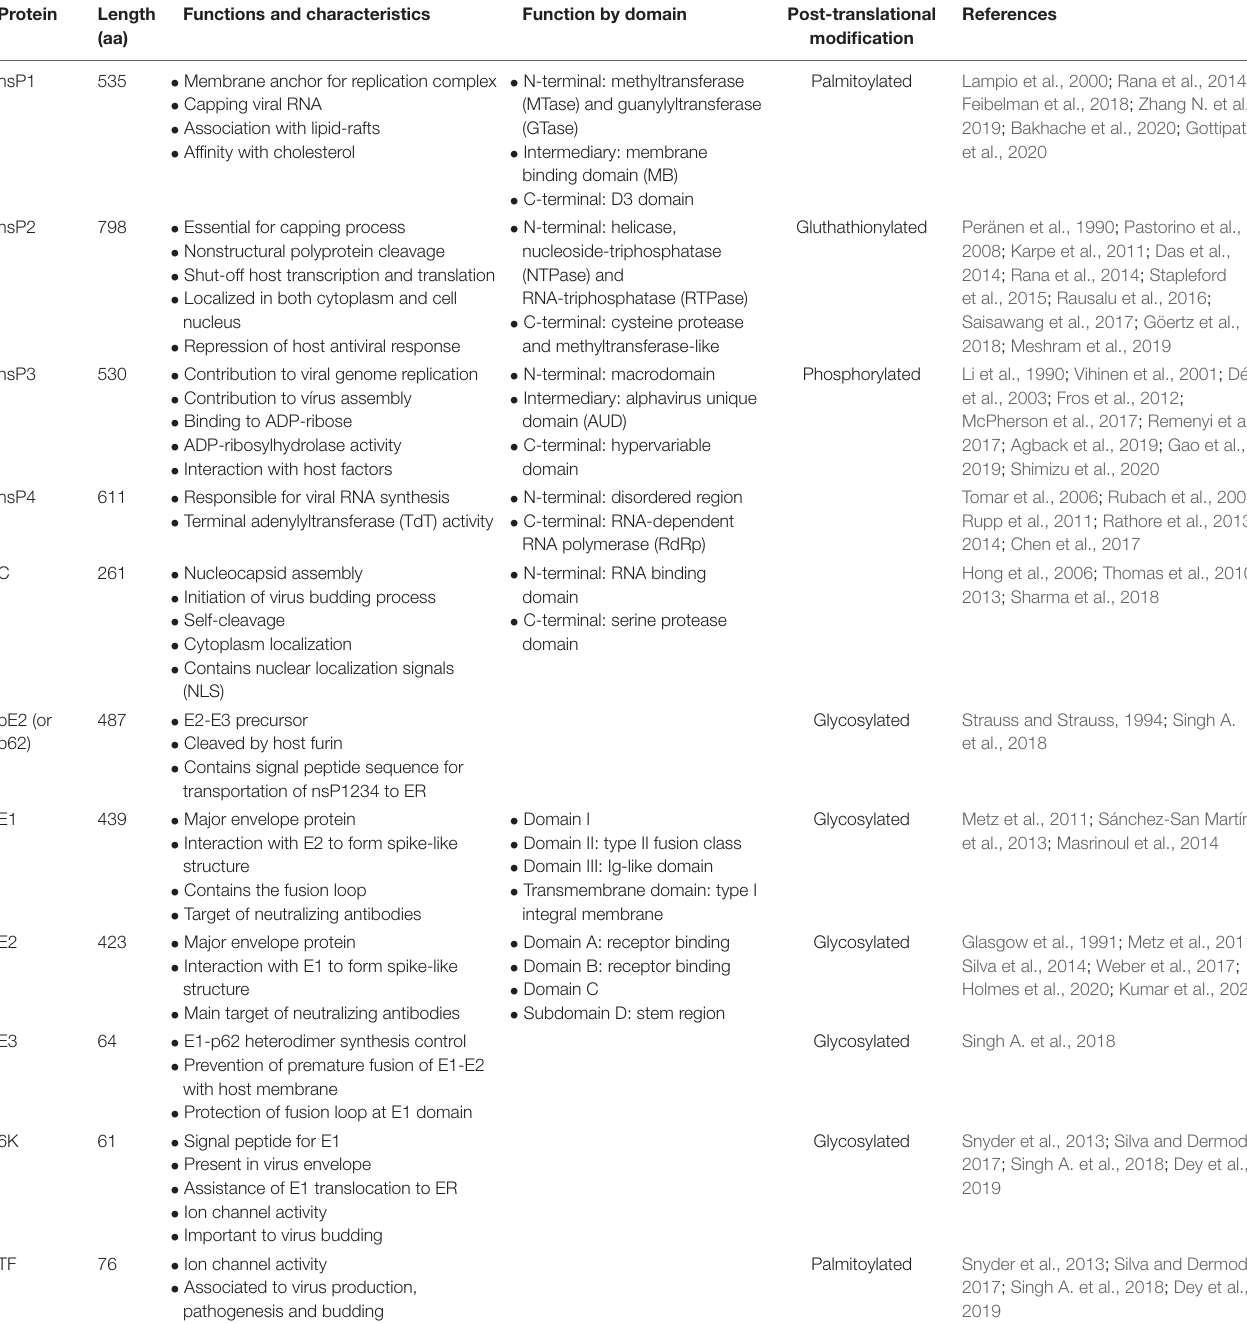
TABLE 1 | Characteristics of CHIKV structural and non-structural